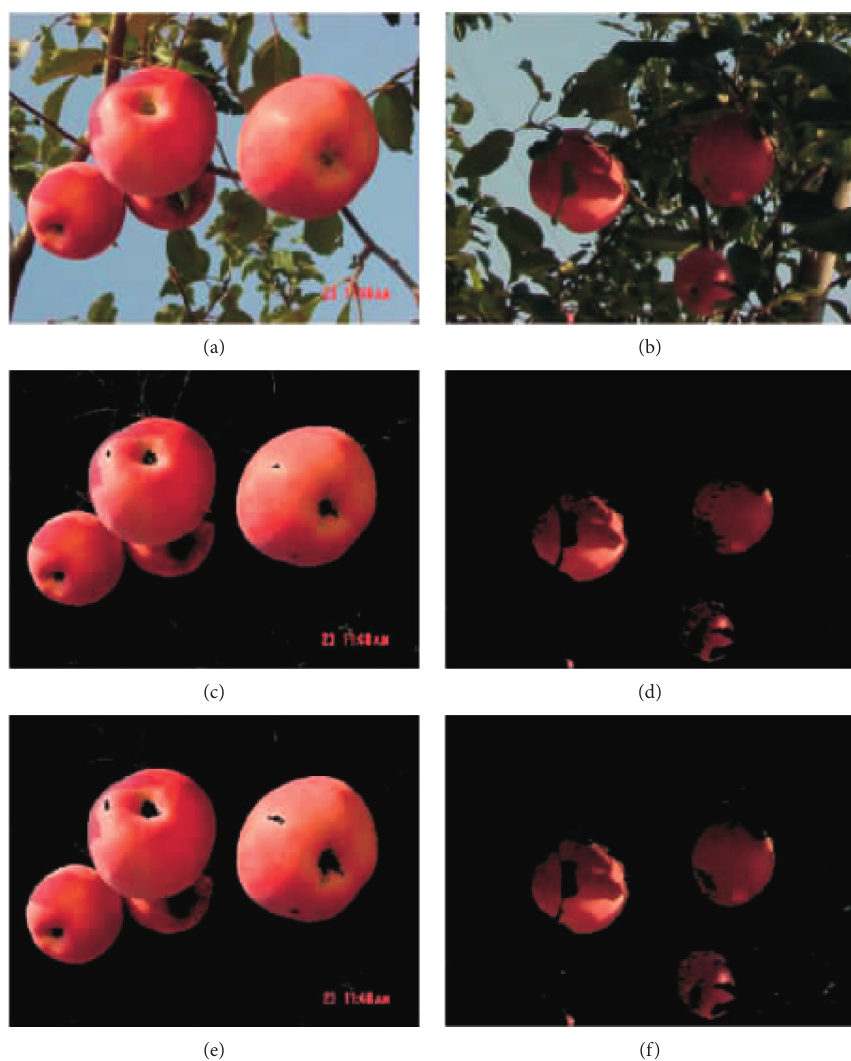
Figure 5: Comparison of the segmentation effects. (a) Original image 1; (b) original image 2; (c) image 1 segmented by fixed threshold; (d) image 2 segmented by fixed threshold; (e) image 1 segmented by OTSU dynamic threshold; (f) image 2 segmented by OTSU dynamic